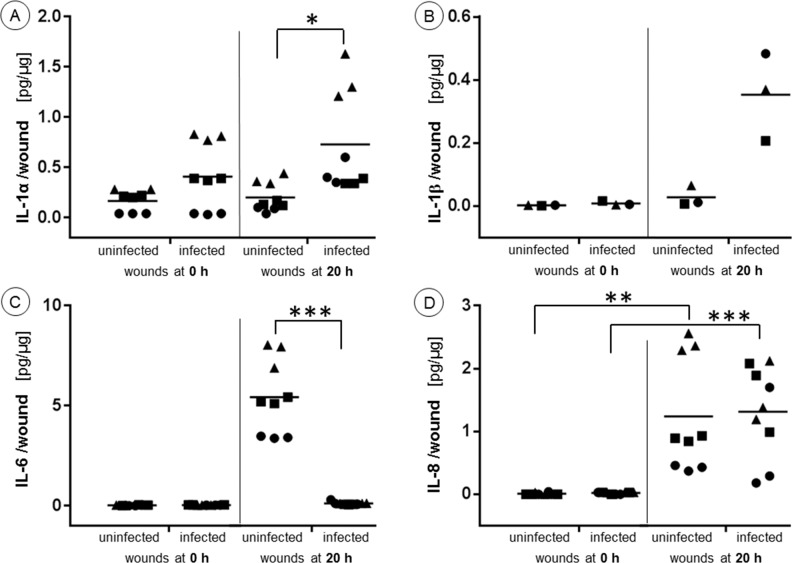
Quantification of selected interleukins in infected and uninfected wounds.(A) IL-1α, (B) IL-1β*, (C) IL-6, and (D) IL-8 concentrations of uninfected and infected wounds after 0 and 20 hours. (●,▴ and ■ represent triplicates of donors 1–3) (*Due to the limited volume of the testing material, triplicates had to be pooled). * p> 0.05, **p>0.01, *** p < 0.001.